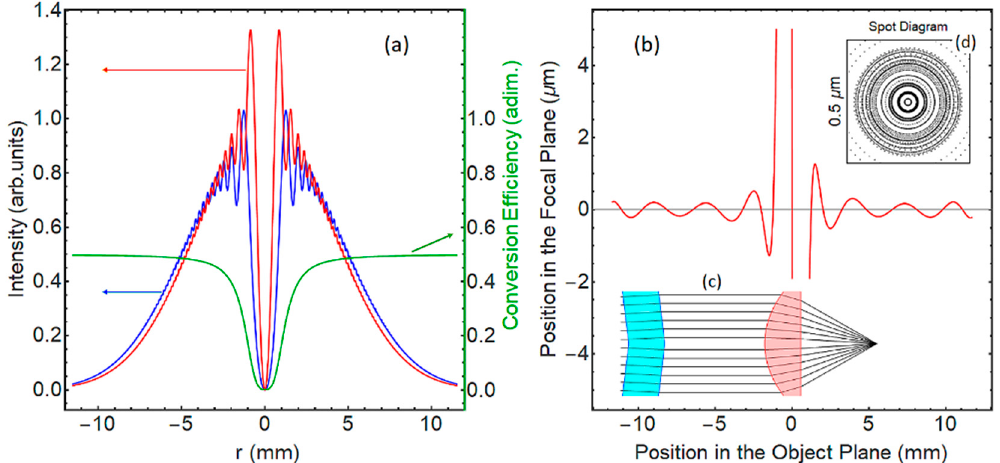
Figure 3. The intensity profile before mode converter (MC) is shown in red, the intensity profile after MC is shown in blue, and the conversion efficiency is shown in green ( a ); the ray-fan diagram is shown in red ( b ); the MC and aspherical lens, with ray-tracing, in longitudinal section view ( c ); ray intersection with the focal plane ( d ).